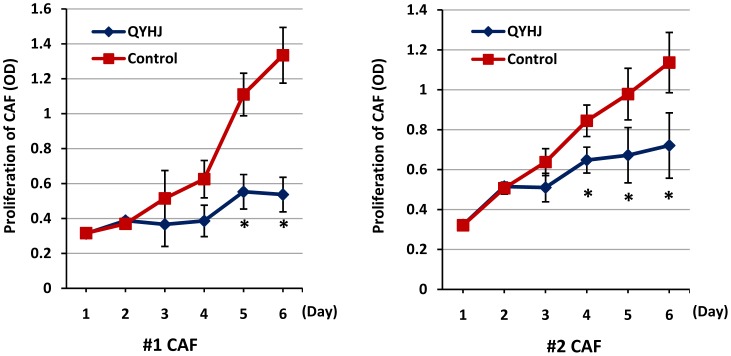
QYHJ inhibited CAF proliferation in vitro.Approximately 5×103 CAFs in 0.1 ml were plated in duplicate wells of 96-well plates. After overnight incubation, the suspension was removed and transferred to DMEM containing 10% QYHJ-Containing Serum or Control-Containing Serum. The cell proliferation indices were assessed daily using the Cell Counting Kit-8. The results are presented as the means ± SD of values obtained in three independent experiments. *P < 0.05.